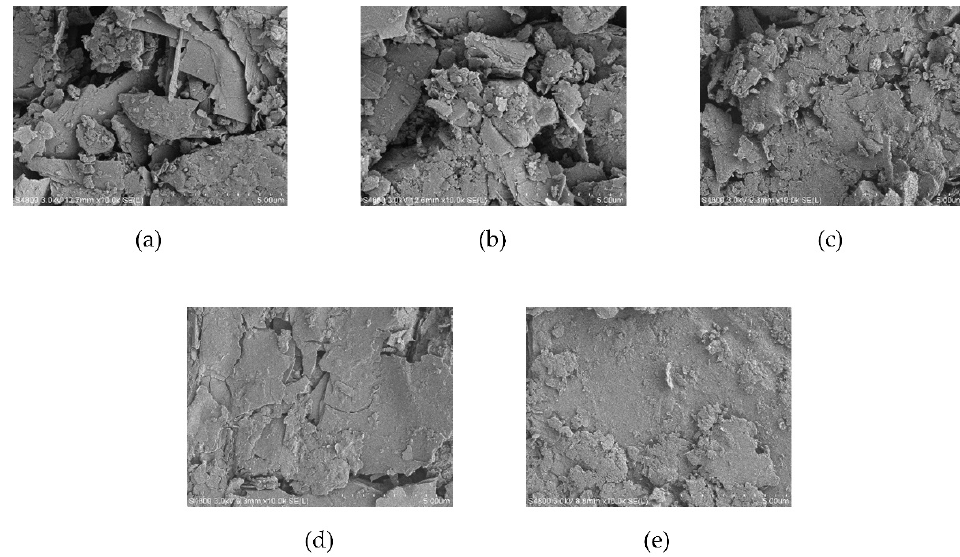
Figure 2. SEM images of tablets with various porosities. From ( a – e ), the porosities are 25.2%, 19.4%, 18.6%, 15.3%, and 12.7%, respectively.